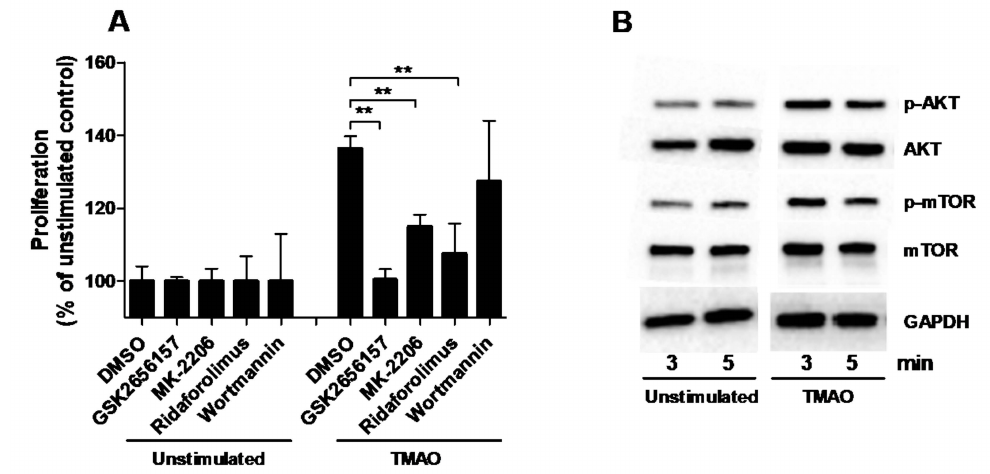
Figure 3. PERK/Akt/mTOR pathway mediates TMAOs proliferative effect on renal fibroblasts. Renal fibroblasts were pre-incubated with DMSO (vehicle), PERK inhibitor GSK2656157 (0.5 µ M), Akt inhibitor MK-2206 (1 µ M), mTOR inhibitor ridaforolimus (1 µ M) or PI3K inhibitor wortmannin (1 µ M) for 1 h prior to TMAO stimulation (300 µ M) for 48 h ( A ) followed by evaluating proliferation. Proliferation is presented as % of unstimulated control. Western blot analysis was conducted to identify differences in protein levels of p-Akt/Akt and p-mTOR/mTOR after TMAO (300 µ M) stimulation for 3 and 5 min ( B ). GAPDH was used as a loading control. Data are presented as mean ± SEM ( n = 3 independent experiments). Asterisks denote statistical significance (** p < 0.01).